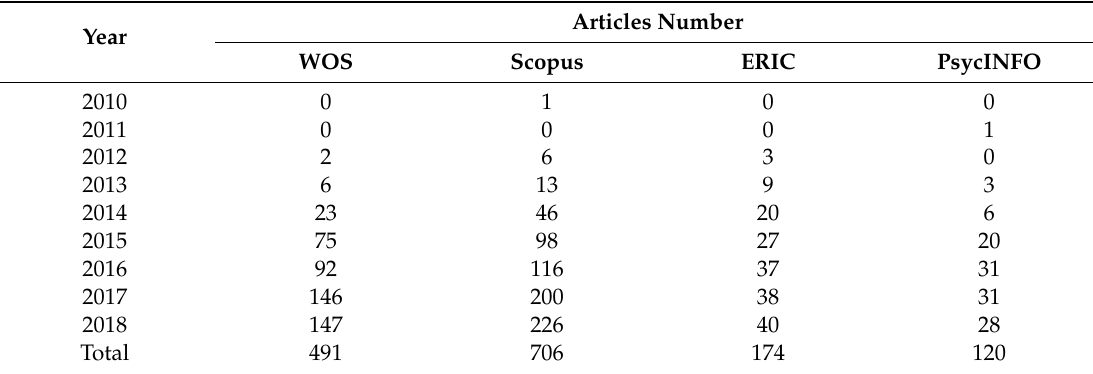
Table 1. Publication per year of scientific articles on the databases.